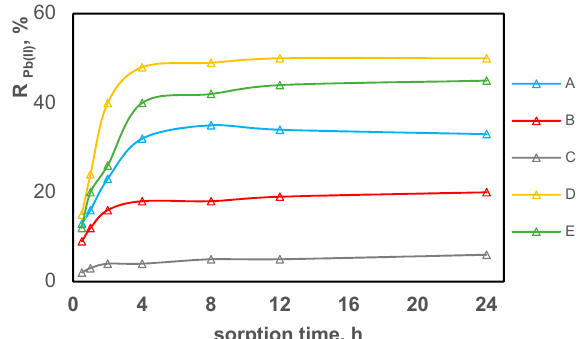
Figure 9. The reduction in lead ion concentration expressed as a percentage of sorption on PVC-based composites promoted with acac depending on the contact duration.